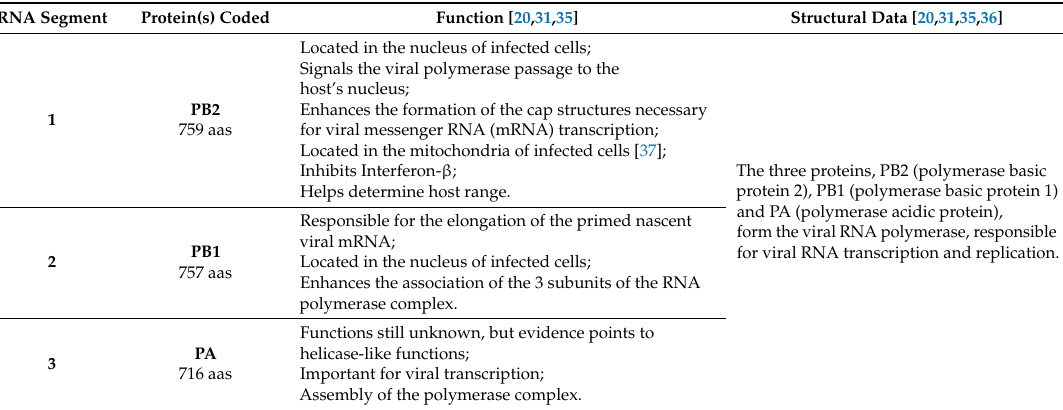
Figure 1. Schematic representation of the influenza virion. The viral genome is depicted highlighting the 8 single-stranded RNA segments (PB2, PB1, PA, HA, NP, NA, M, and NS) organized into ribonucleoproteins and here displayed by their decreasing size. Each ribonucleoprotein complex includes one trimeric viral RNA polymerase (PB1, PB2, and PA), in addition to nucleoproteins wrapped in viral RNA. (M1—viral matrix protein; PB1—polymerase basic protein 1; PB2—polymerase basic protein 2; PA—polymerase acidic protein; M2—ion channel). Table 1. Summary of the functions and interactions of the proteins coded by each RNA segment of influenza viruses (aas, amino acids).